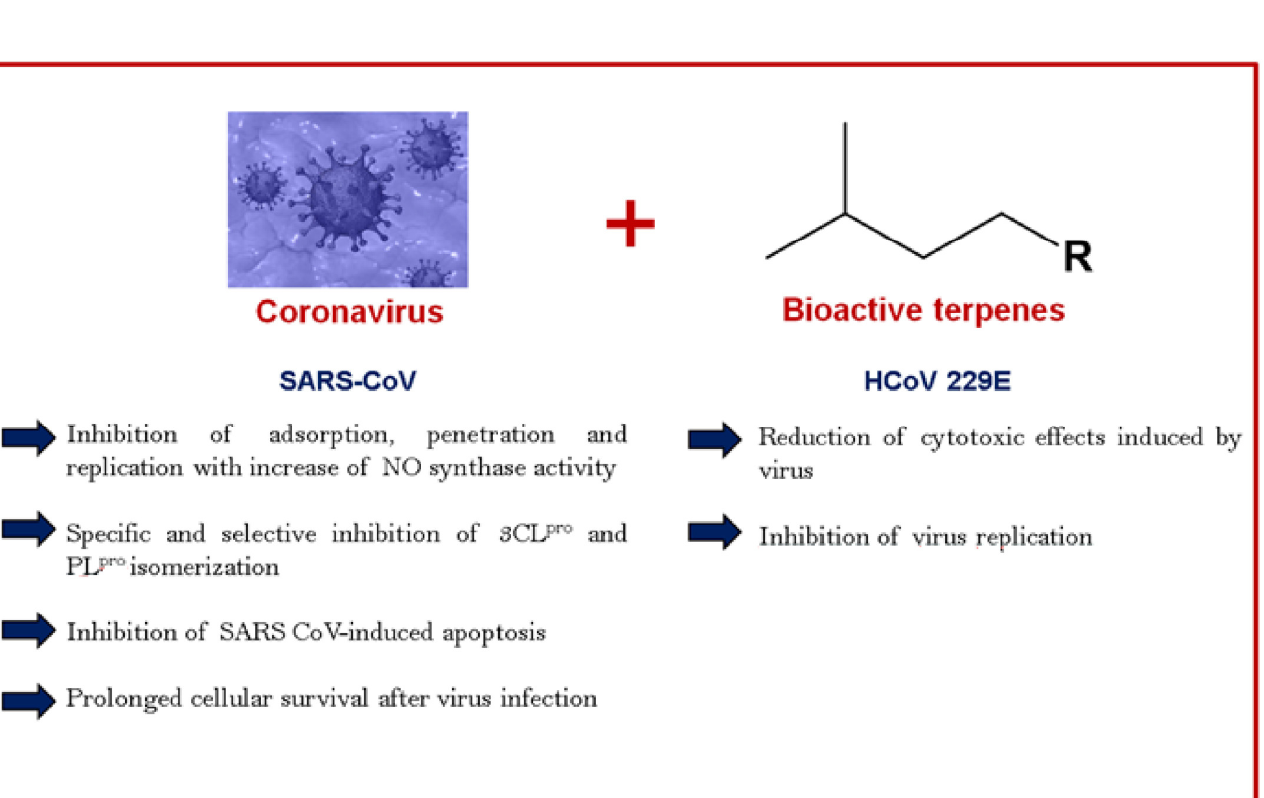
Figure 2. Main mechanisms of action of terpenes against coronaviruses